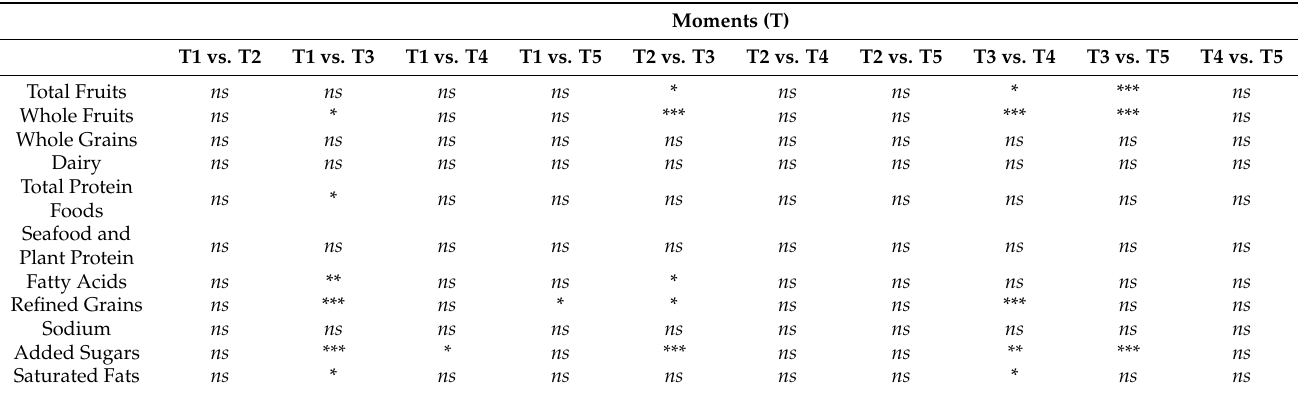
Table 6. Post hoc comparisons of the number of portions of each component consumed among moments